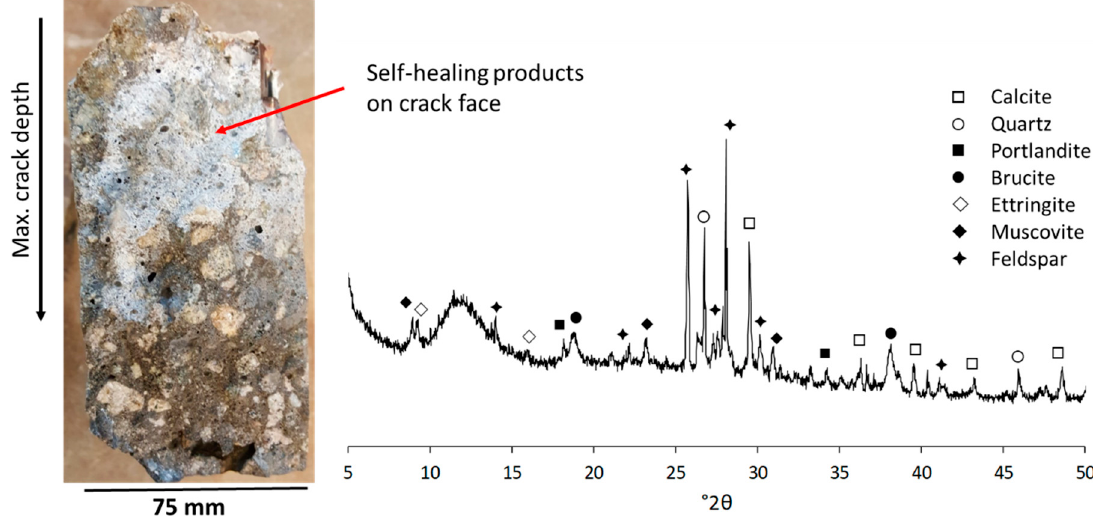
Figure 7. Left: Self-healing products on crack face in the tidal zone of PC-4SF20FA, Right: XRD diffractogram of the self-healing product. The wide hump between 10–15 °2 θ indicates the desiccator wax used for the sample preparation. Table 9. Variation of mineralogy of self-healing products with crack depth in